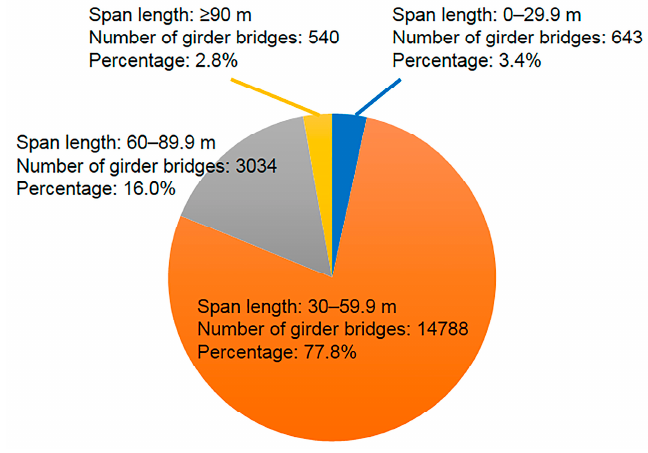
Figure 6. Numbers of girder bridges within different ranges of span lengths.